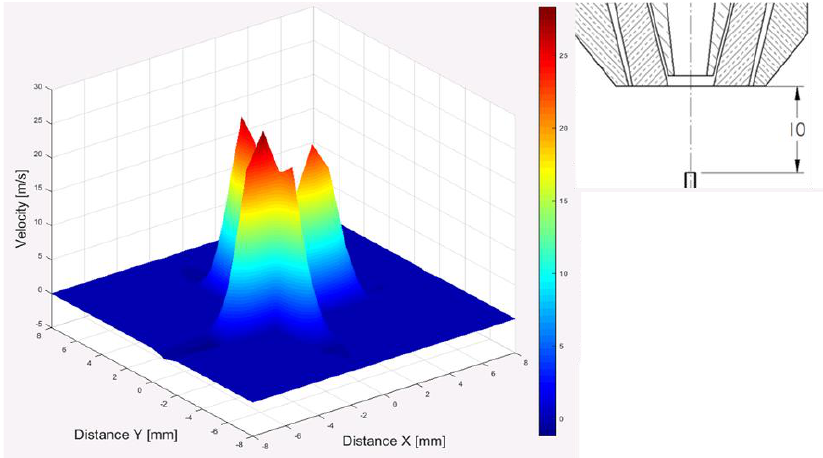
Figure 17: gas velocity measured at 10 mm from the nozzle